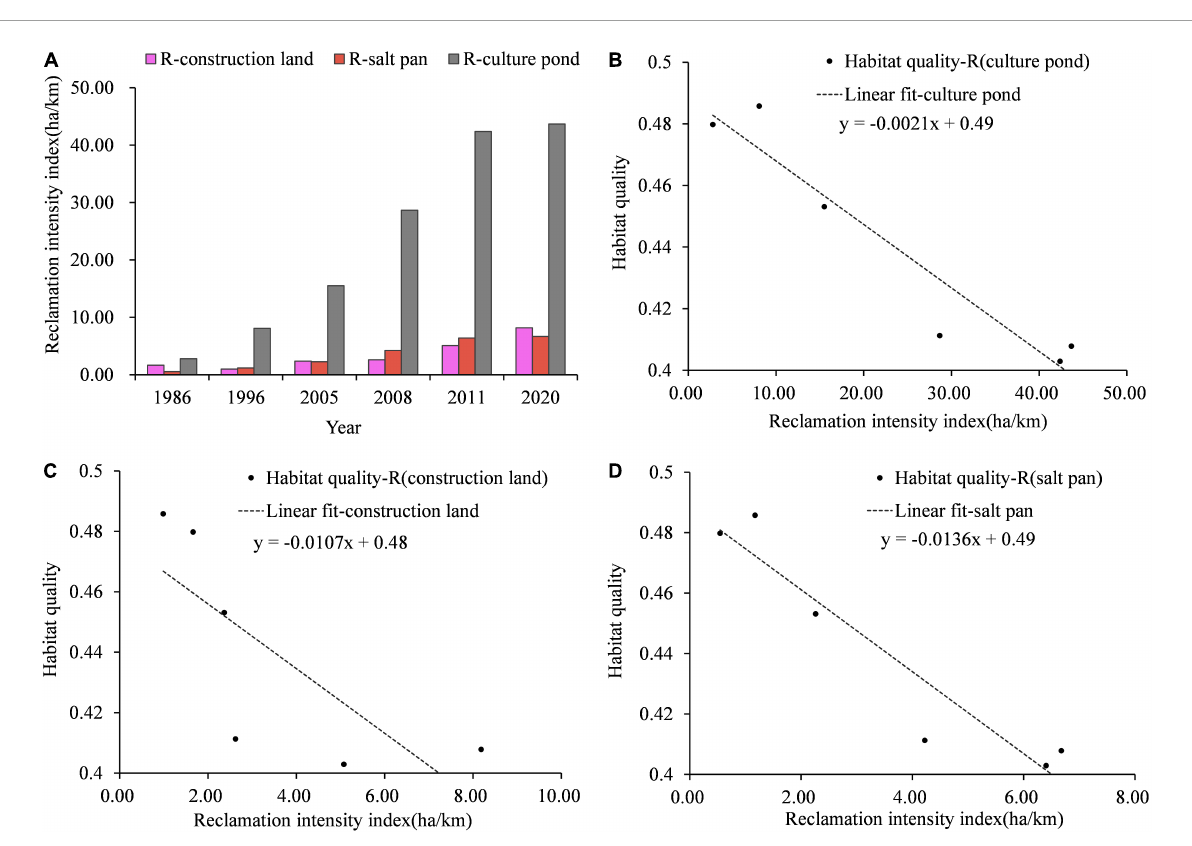
FIGURE10 The results of the reclamation intensity index (A) , the simple linear relationship between the reclamation intensity index and habitat quality (B–D) .